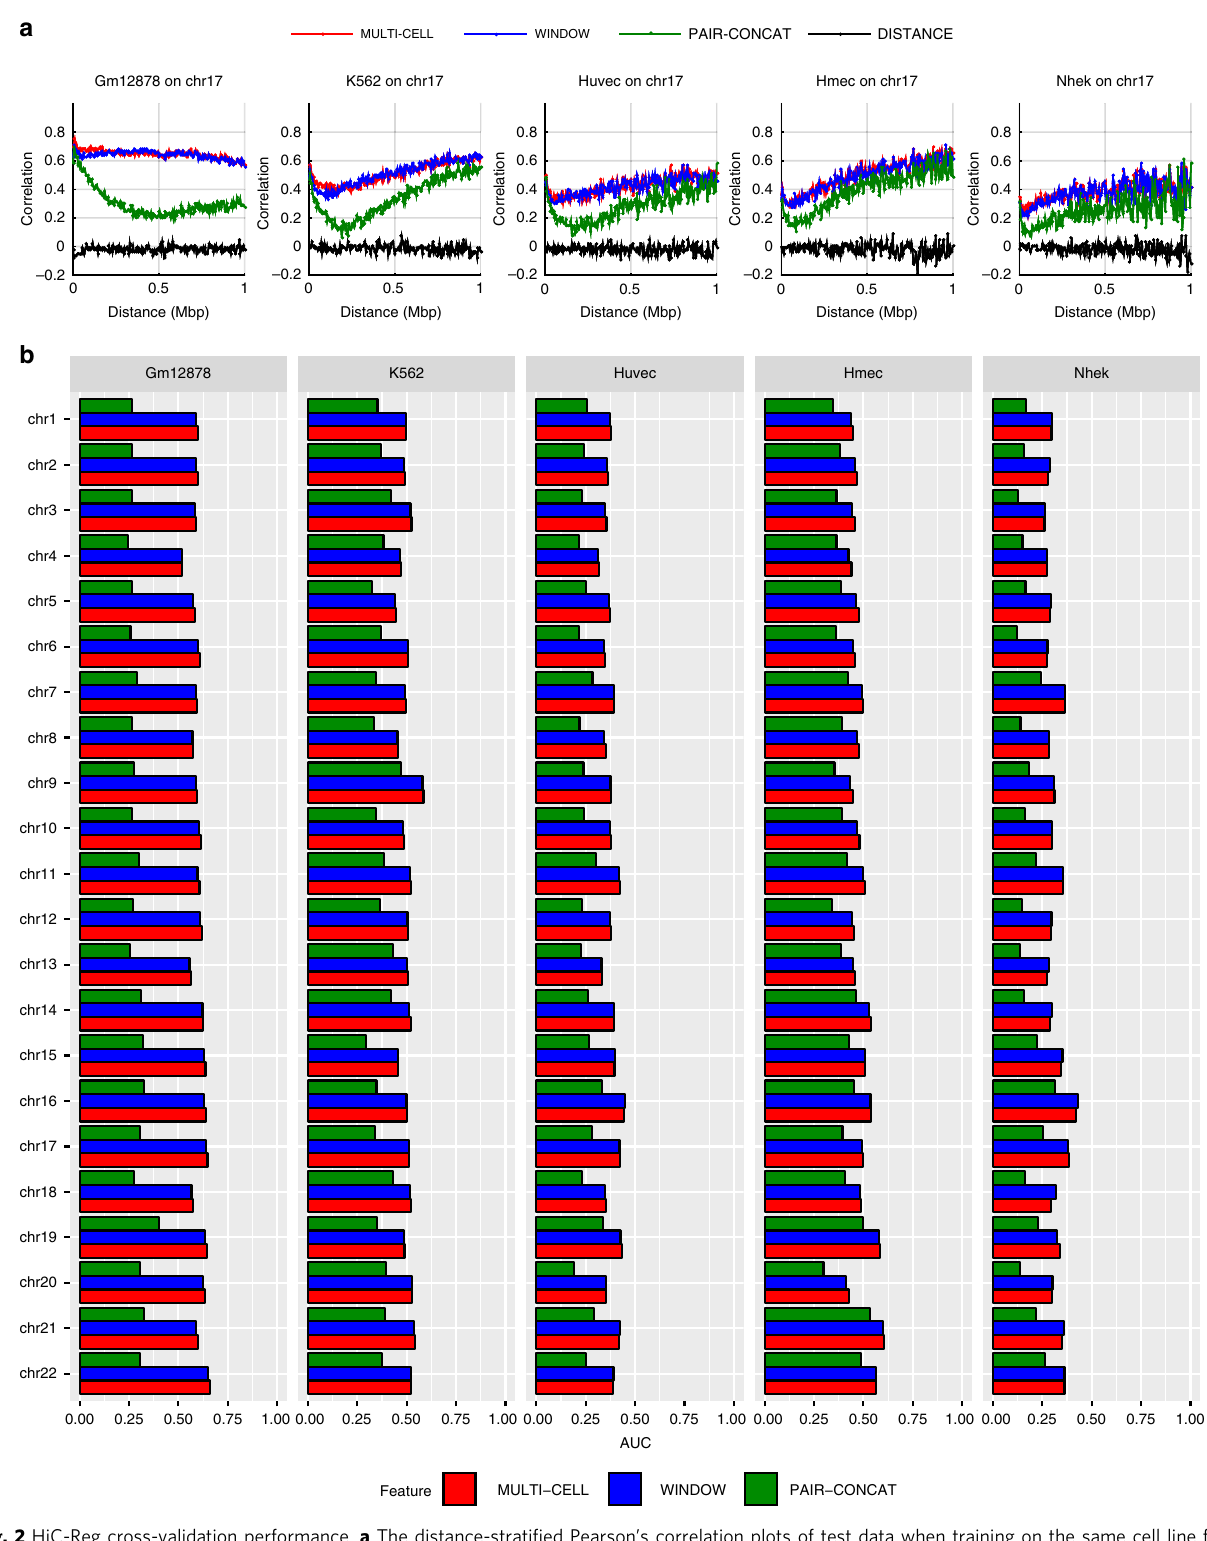
Fig. 2 HiC-Reg cross-validation performance. a The distance-strati fi ed Pearson ’ s correlation plots of test data when training on the same cell line for chromosome 17 in fi ve cell lines: Gm12878, K562, Huvec, Hmec, Nhek. The x -axis corresponds to a particular distance bin and the y -axis corresponds to the Pearson ’ s correlation of the counts predicted by HiC-Reg for pairs at a particular distance and the true counts. The correlation plots for three types of feature representations of pairs are shown: MULTI-CELL, WINDOW, and PAIR-CONCAT. b Area under the curve (AUC) for the distance-strati fi ed Pearson ’ s correlation in all chromosomes for each of the fi ve cell lines. The AUC is computed for test pairs using fi vefold cross-validation. Source data are provided as a Source Data fi